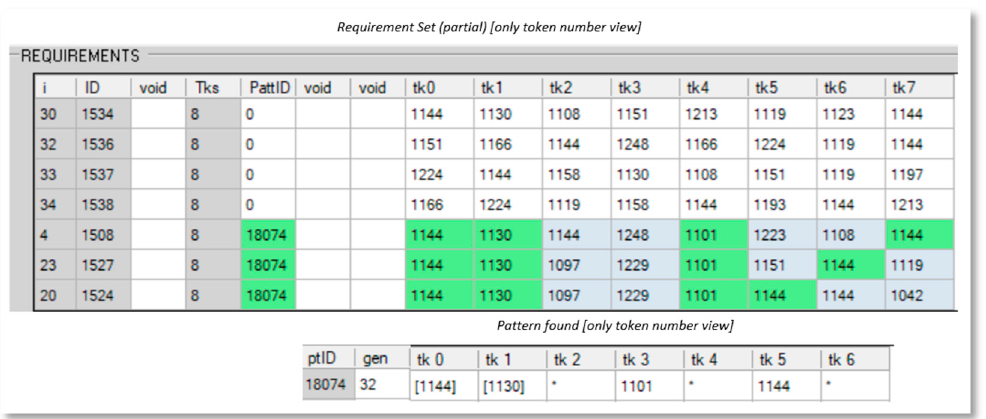
Table 5. Requirements Sets are used as inputs to the experiment.